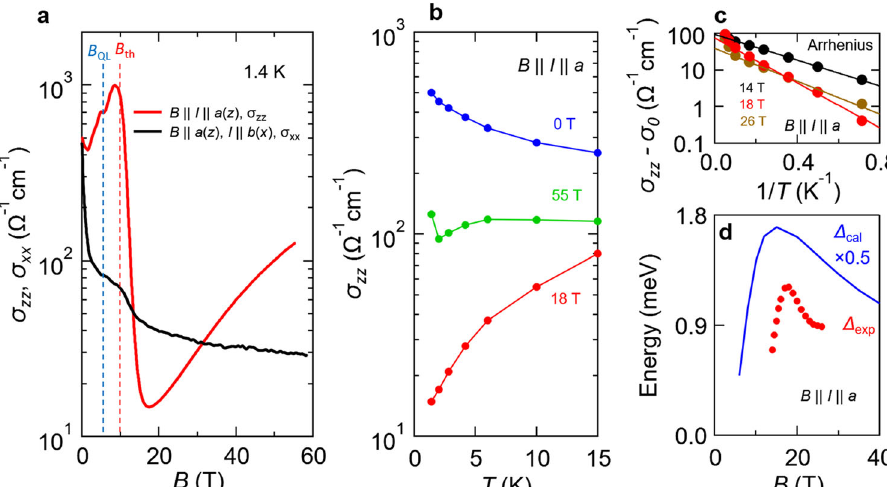
Fig. 2 Temperature dependence of conductivity and estimation of activation energy. a Comparison of the magnetoconductivity in the longitudinal con fi guration ( B || I || a ( z )) and that in the transverse con fi guration ( B || a ( z ), I || b ( x )). b Temperature dependence of conductivity at 0, 18, and 55 T. c Temperature dependence of conductivity plotted as a function of 1/ T at 14, 18, and 26 T for the Arrhenius model. d Magnetic ’ s model ( Δ fi eld dependence of activation energy extracted by Arrhenius model ( Δ exp ) and the gap size of CDW calculated by Fukuyama cal ).